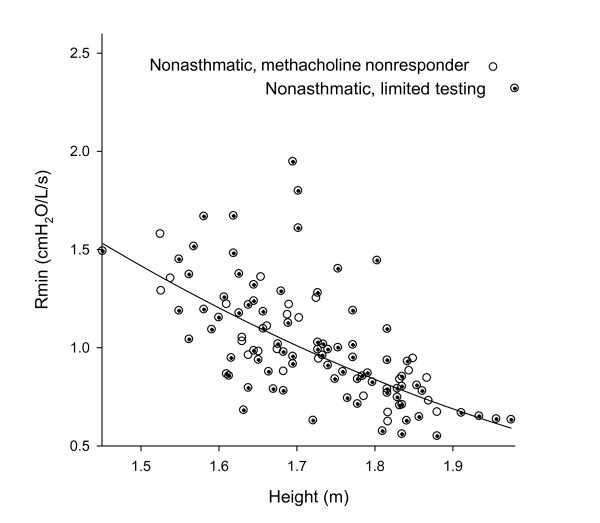
Plot of Rmin versus height for nonasthmatic subjects. Rmin (cmH2O/L/s) is plotted by height (m) for 100 nonasthmatic subjects, including 84 subjects recruited for limited testing (+) and 26 nonasthmatic methacholine nonresponders (0), as described in the text. The superimposed regression line is derived from a second order linear regression (r2 = 0.60).